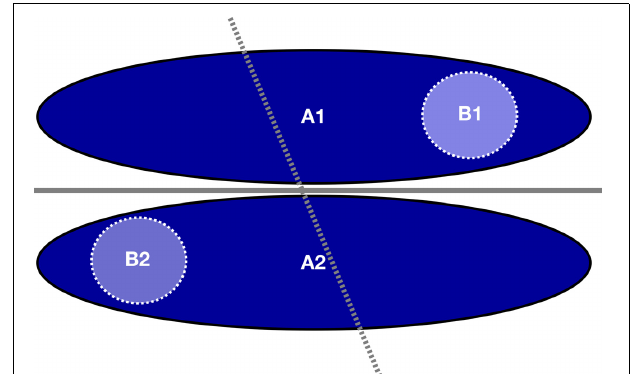
FIGURE 9 | Example of how a classifier on a subset of the total sample (light blue circles, dotted line) fails to adequately classify the total sample (dark blue ellipsoids, solid line) though the latter can be classified by itself, even yielding perfect classification accuracy on the smaller